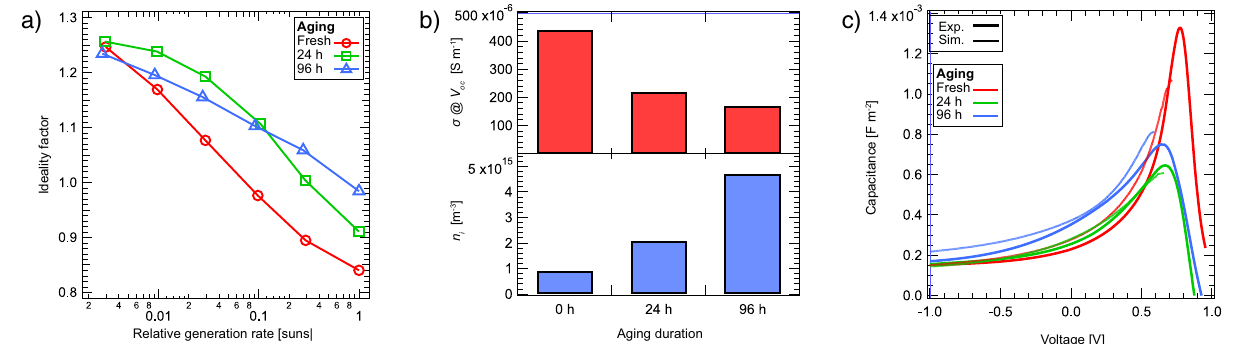
Fig. 3 Trap formation impacting charge recombination and transport. a Ideality factor of fresh and aged devices for illumination intensities ranging from 0.003 suns to 1 sun. b The electrical conductivity σ near open-circuit conditions and the estimated intrinsic charge carrier density n i , for various aging durations. c Experimental and simulated CV curves under 1